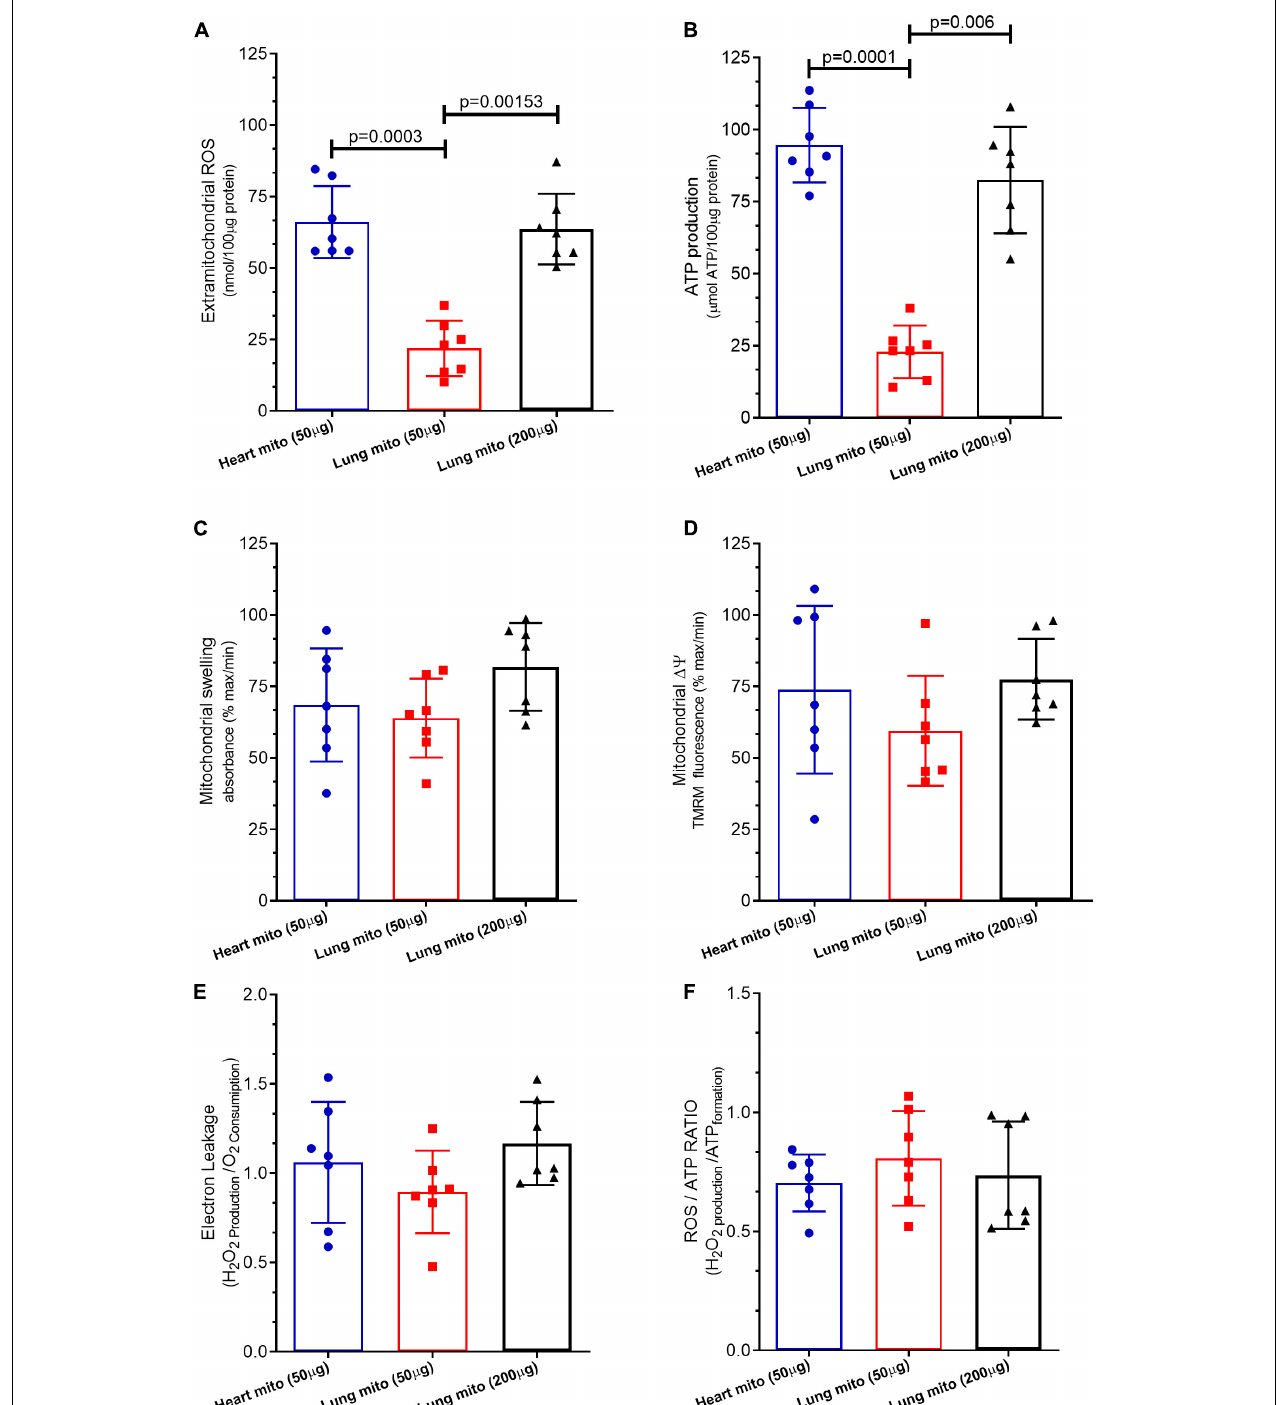
FIGURE 4 | Mitochondrial products and characteristics. (A) Reactive oxygen species (ROS) production, (B) adenosine triphosphate (ATP) production, (C) mitochondrial swelling, (D) mitochondrial transmembrane potential (m (cid:49) ψ ), (E) electron leakage, and (F) ROS/ATP ratio of isolated mitochondria from mice heart and lung. Heart mito (50 µ g) represents the group of isolated mitochondria from hearts. Lung mito (50 µ g) indicates the group of isolated mitochondria from lungs with loading of 50 µ g. Lung mito (200 µ g) signals the group of isolated mitochondria from lungs with loading of 200 µ g. Each symbol represents one animal. Data are expressed as mean ± standard deviation. Horizontal square brackets indicate significantly different differences and the corresponding p